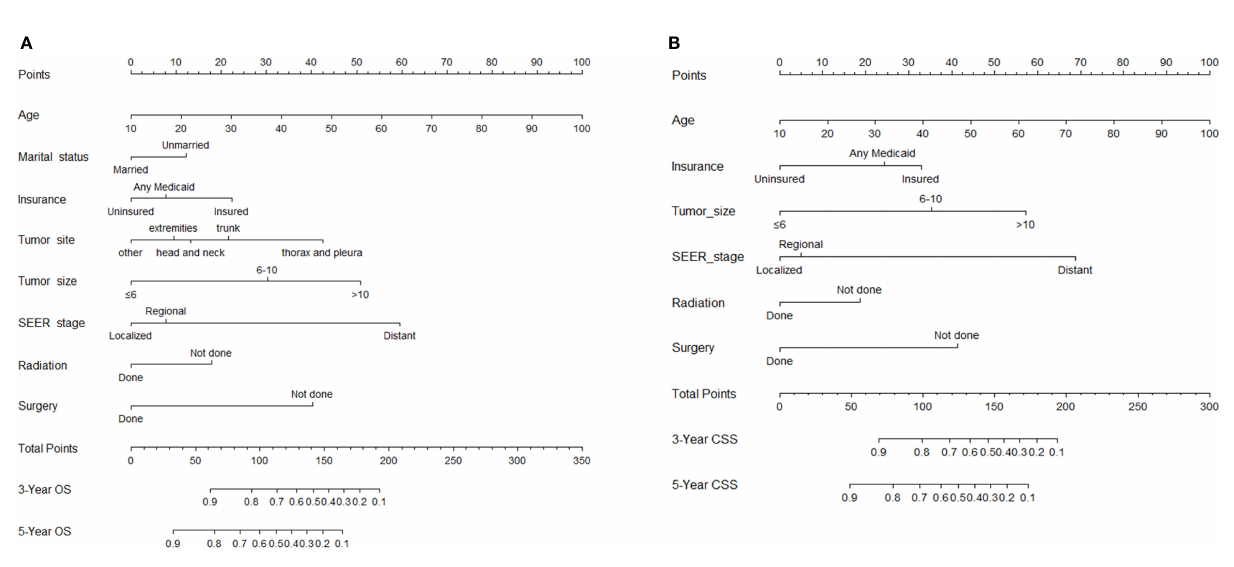
FIGURE 2 | Nomogram for predicting 3- and 5-year overall survival (OS) (A) and cancer-speci fi c survival (CSS) (B) for synovial sarcoma (SyS)